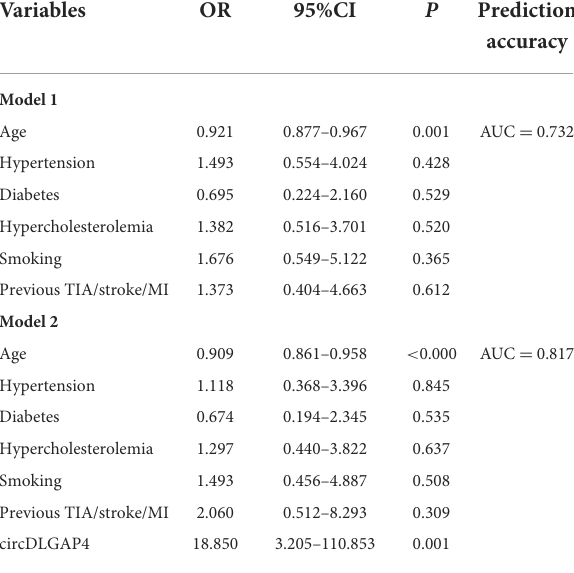
TABLE 5 The circDLGAP4 level in the multivariable logistic regression model for AIS outcome prediction.